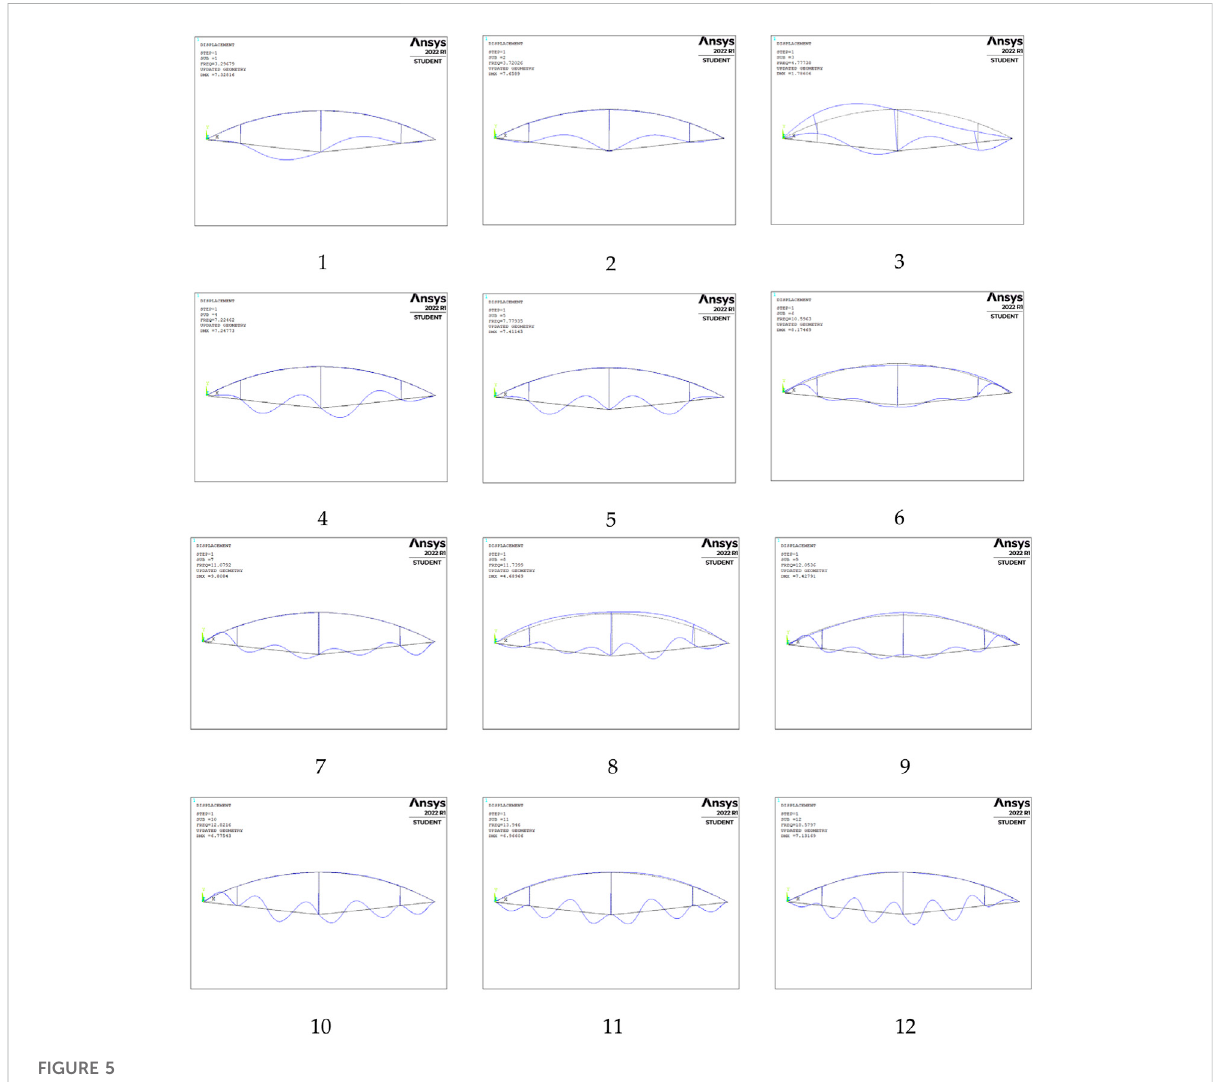
FIGURE 5 1st to 12th mode